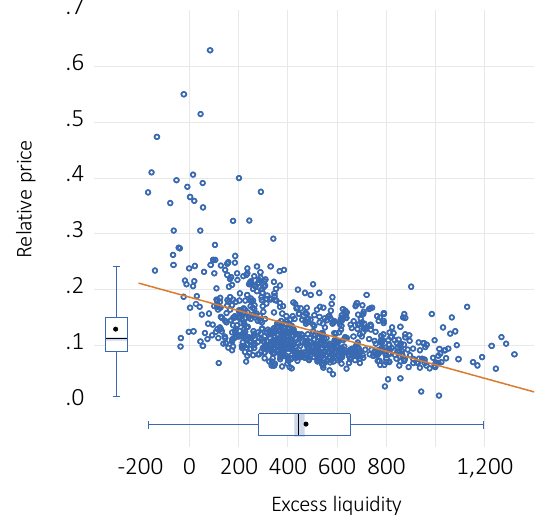
Figure 2. Relative price of liquidity subject to net excess liquidity